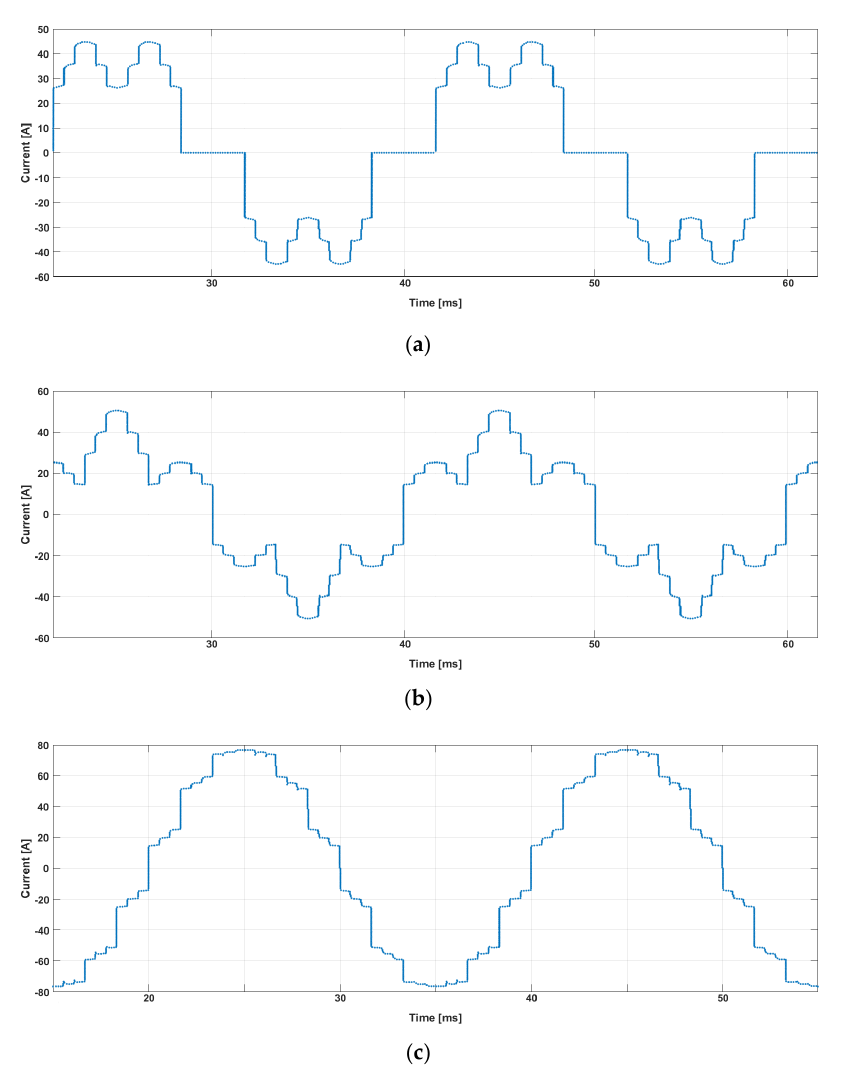
Figure 2. Waveform of selected signals for the rectifier with the voltage modulator: ( a ) current of the primary side of the transformer with star-star connection, ( b ) current of the primary side of the transformer with star-delta connection ( c ) waveform of the resultant grid current .